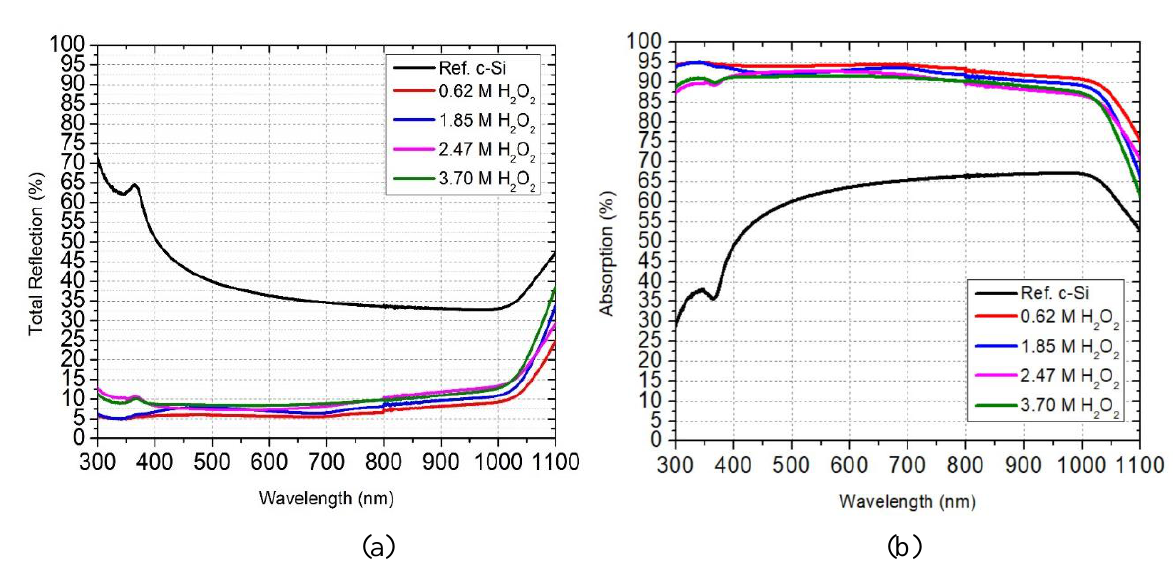
Figure 4: (a) Reflection curves (b) Absorption curves of b-Si nanowires etched with different H O concentrations; W: 0.62 M, X: 1.85 M, Y: 2.47 M, Z: 3.70 2 2